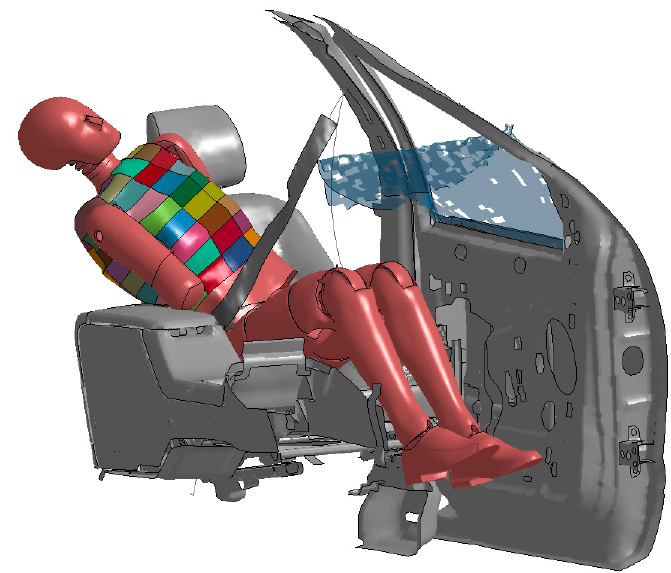
Figure 10. Position 2—ATD at 2300 ms with right thorax impacting against the centre console.